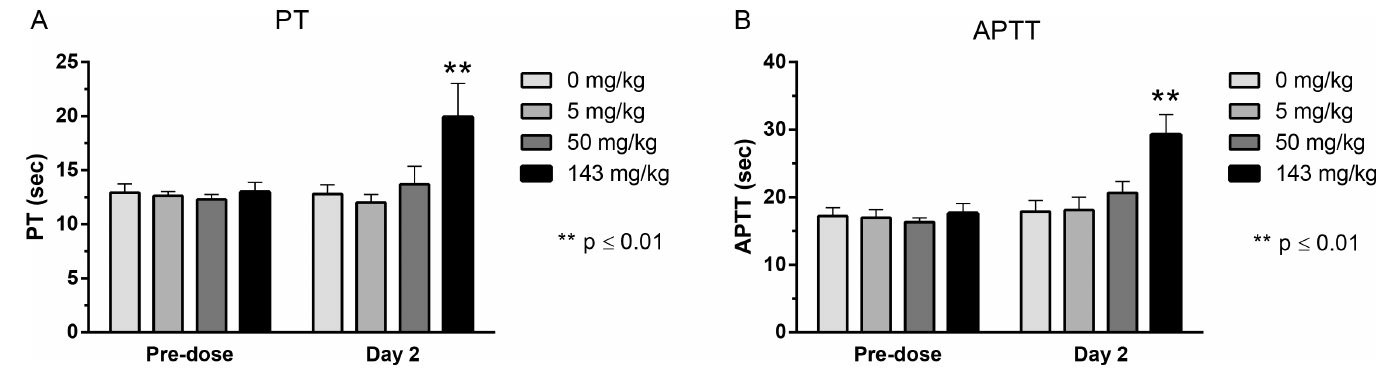
Fig 1. Effect on HSA-NEPv on PT and APTT in cynomolgus monkeys. Mean ( ± SD) PT (A) and APTT (B) were measured in male cynomolgus monkeys four days before dosing (Predose) and 24 h after administration (Day 2) of HSA-NEPv at dose levels of 0 (vehicle control), 5, 50 or 143 mg/kg (n = 3). ** P < 0.01 compared with control.